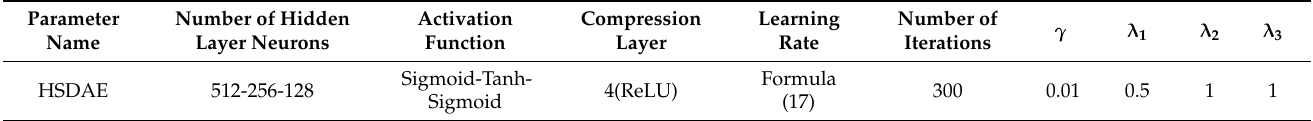
Table 5. The parameter settings of HDSAE in the private data